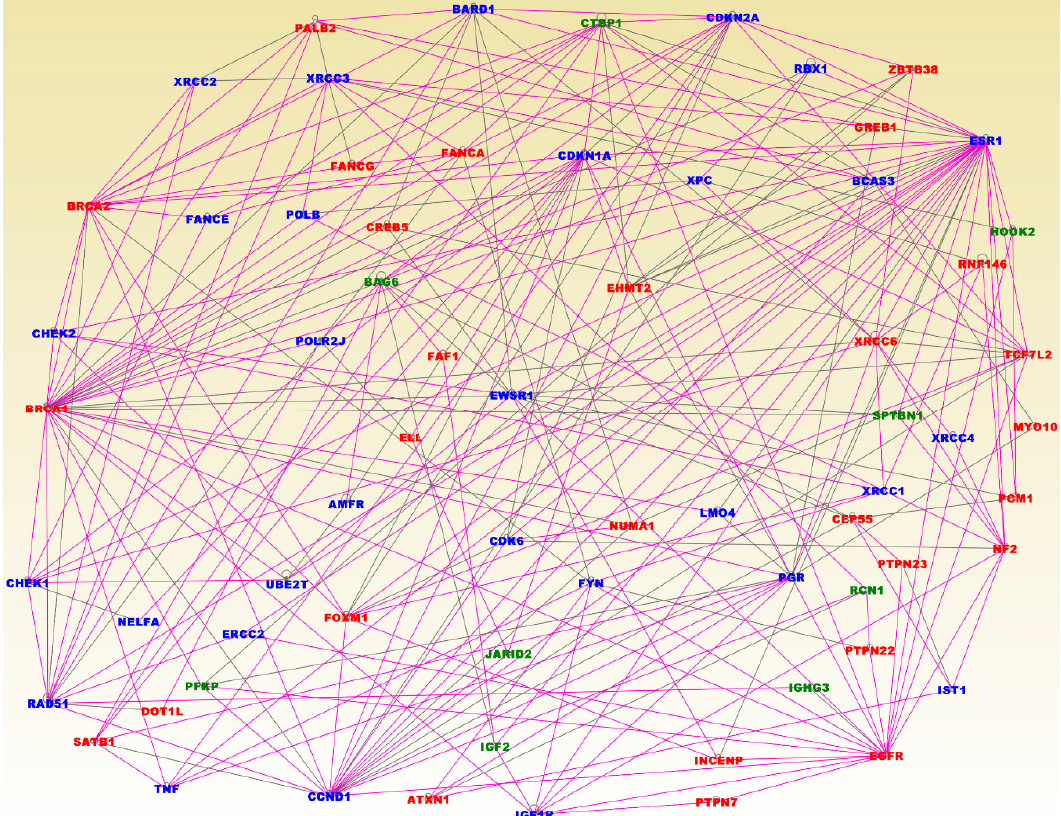
Figure 5. Gene regulatory networks of functionally related genes enriched for germline, somatic and epigenomic alterations. Genes containing germline, somatic and epigenomic alterations are in red fonts. Highly somatic mutated genes containing epinomic changes are shown in blue fonts. Highly epigenetically altered genes containing germline mutations are shown in green fonts.